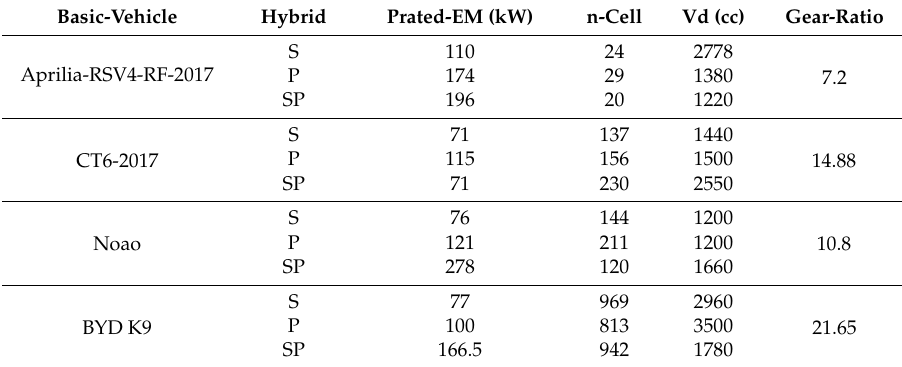
Table 1. Classification of CsTs.